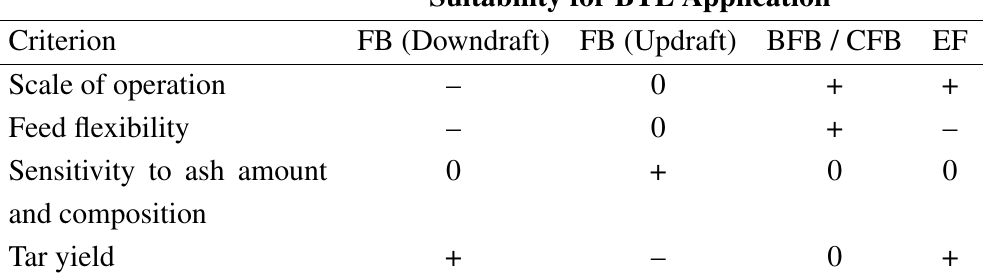
Table 6 . Response of the main characteristics of the established conversion processes to application criteria related to the syngas production for the synthesis of liquid biofuels. Symbols used: + (suitable), 0 (less suitable), – (not